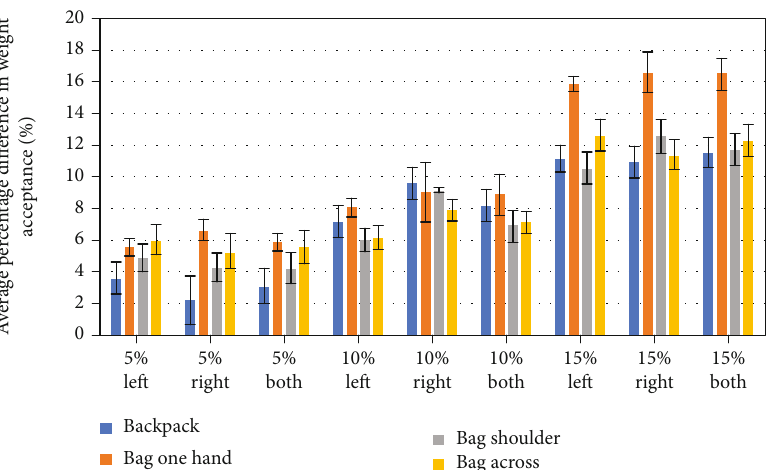
Bag shoulder Bag across